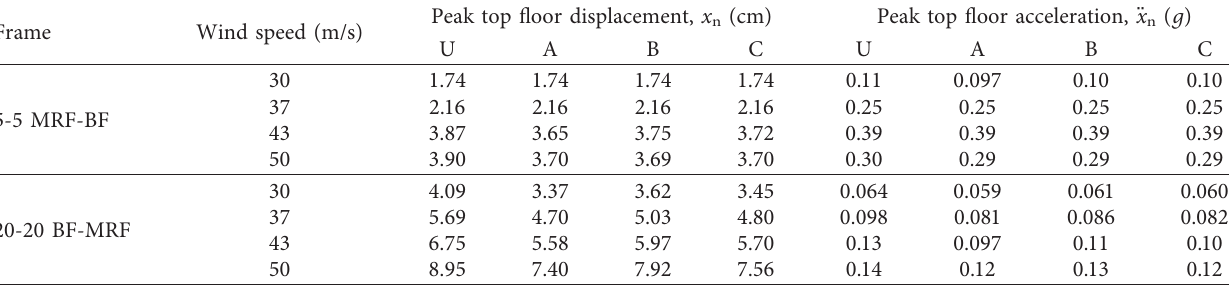
Table 9: Peak top floor displacement and acceleration responses of dissimilar connected buildings for equal storey height under simulated wind forces for different gust speeds.